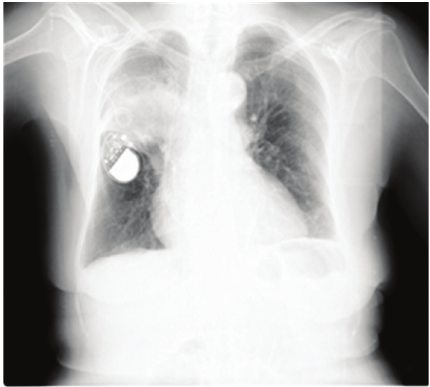
Figure 1: Chest X-ray revealing a heterogeneous hypotransparency in the right hemithorax upper third.